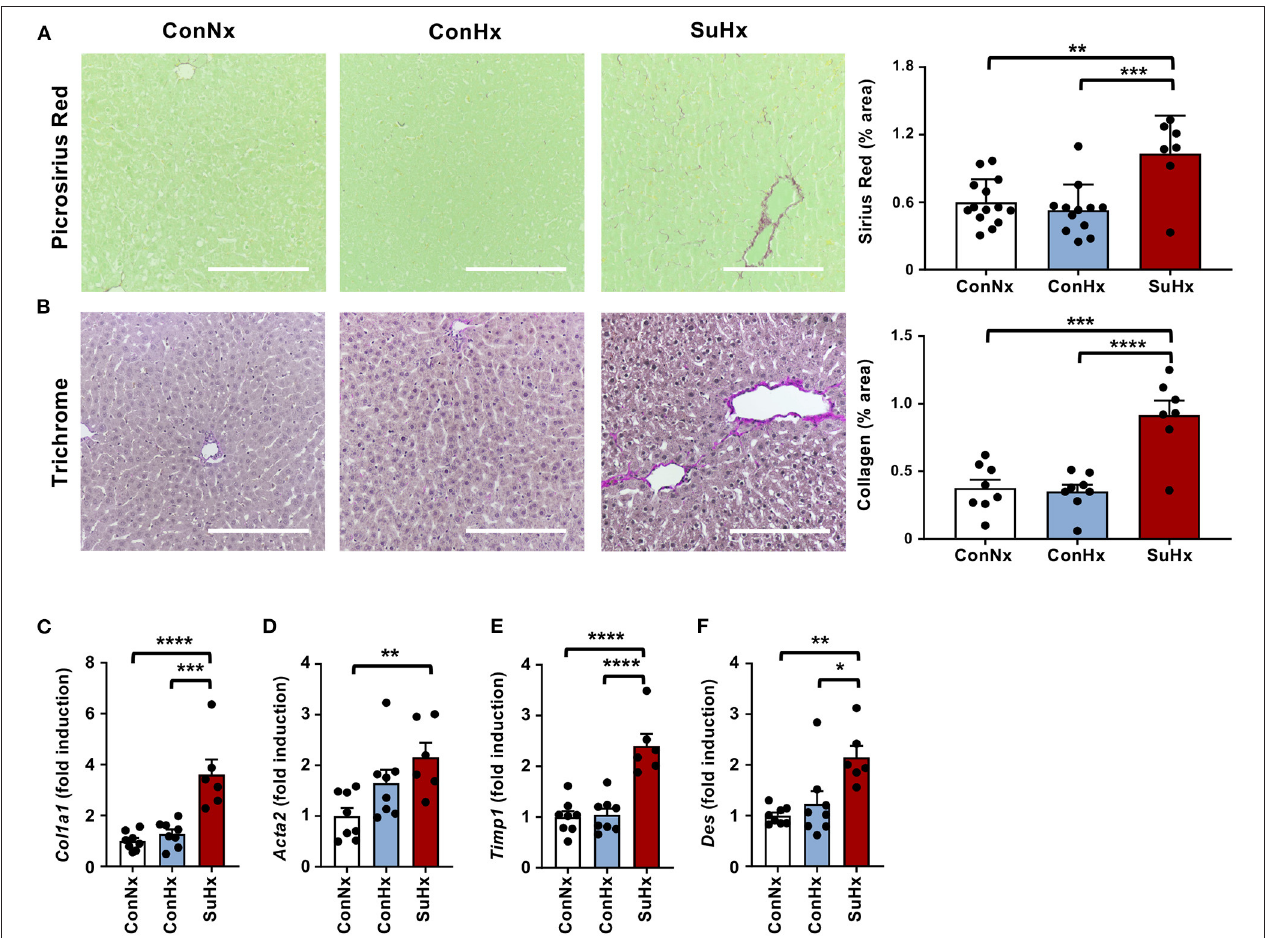
FIGURE 3 | PAH leads to increased liver fibrosis in the SU5416/hypoxia model. (A) Representative pictures and quantification of picrosirius red stained livers of the analyzed rats. ConNx n = 13, ConHx n = 12, SuHx n = 7. (B) Representative pictures and quantification of Masson’s trichrome staining. (C–F) Relative expression of fibrogenic markers collagen 1a1 ( Col1a1 ), alpha smooth muscle actin ( Acta2 ), TIMP metallopeptidase inhibitor 1 ( Timp1) and desmin ( Des ) determined by qPCR from whole livers. Means ± SEM, ConNx n = 8, ConHx n = 8, SuHx n = 7, ANOVA-Bonferroni post-hoc test, * p < 0.05, ** p < 0.01, *** p < 0.001, **** p < 0.0001, Scale bars: 100 µ